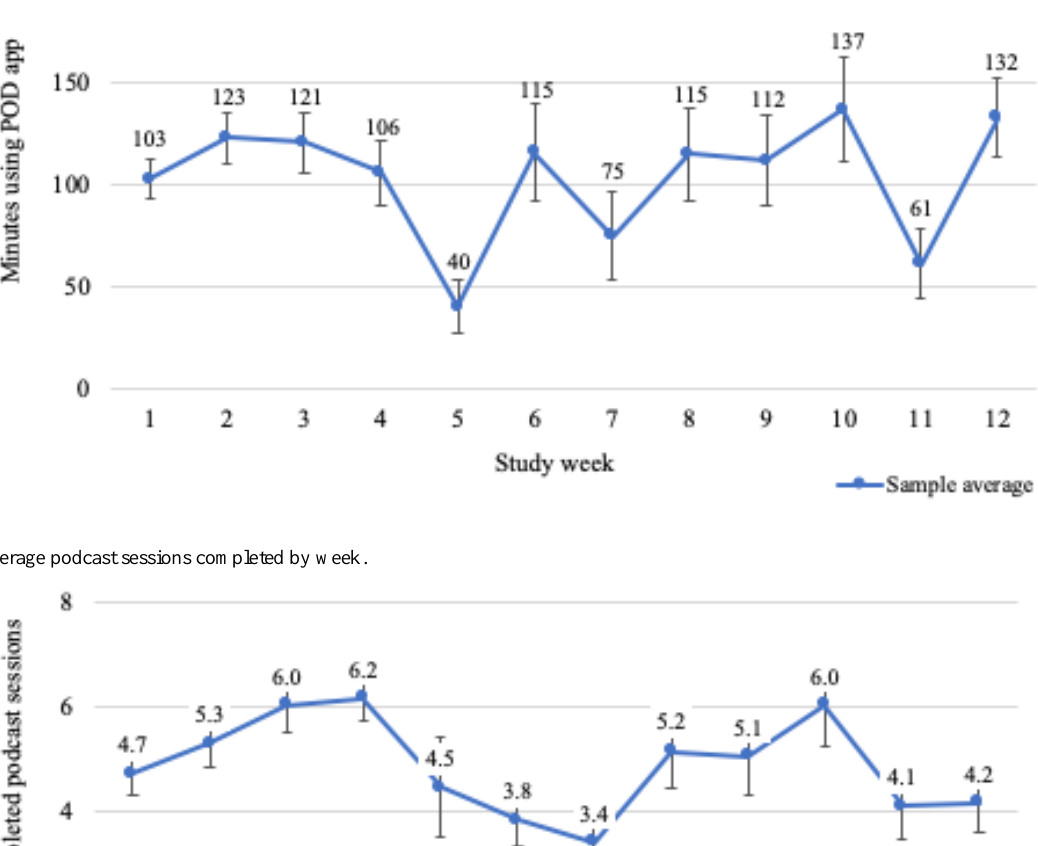
Figure 4. Average minutes using podcast app by week.